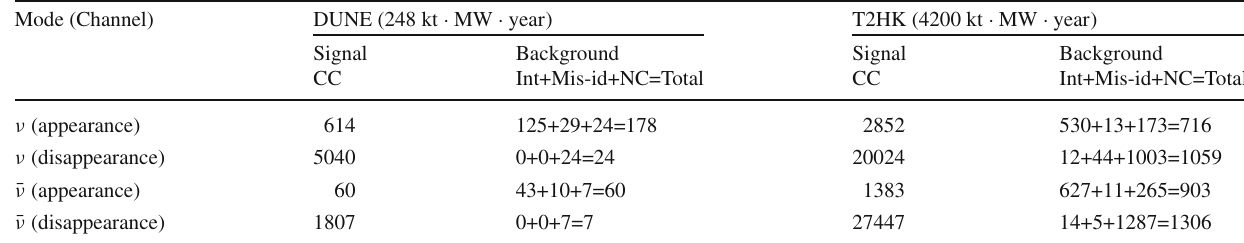
(see Table 1). Here “Int” means intrinsic beam contamination, “Mis- id” represents mis-identified muon events, and “NC” stands for neutral current. See text for other